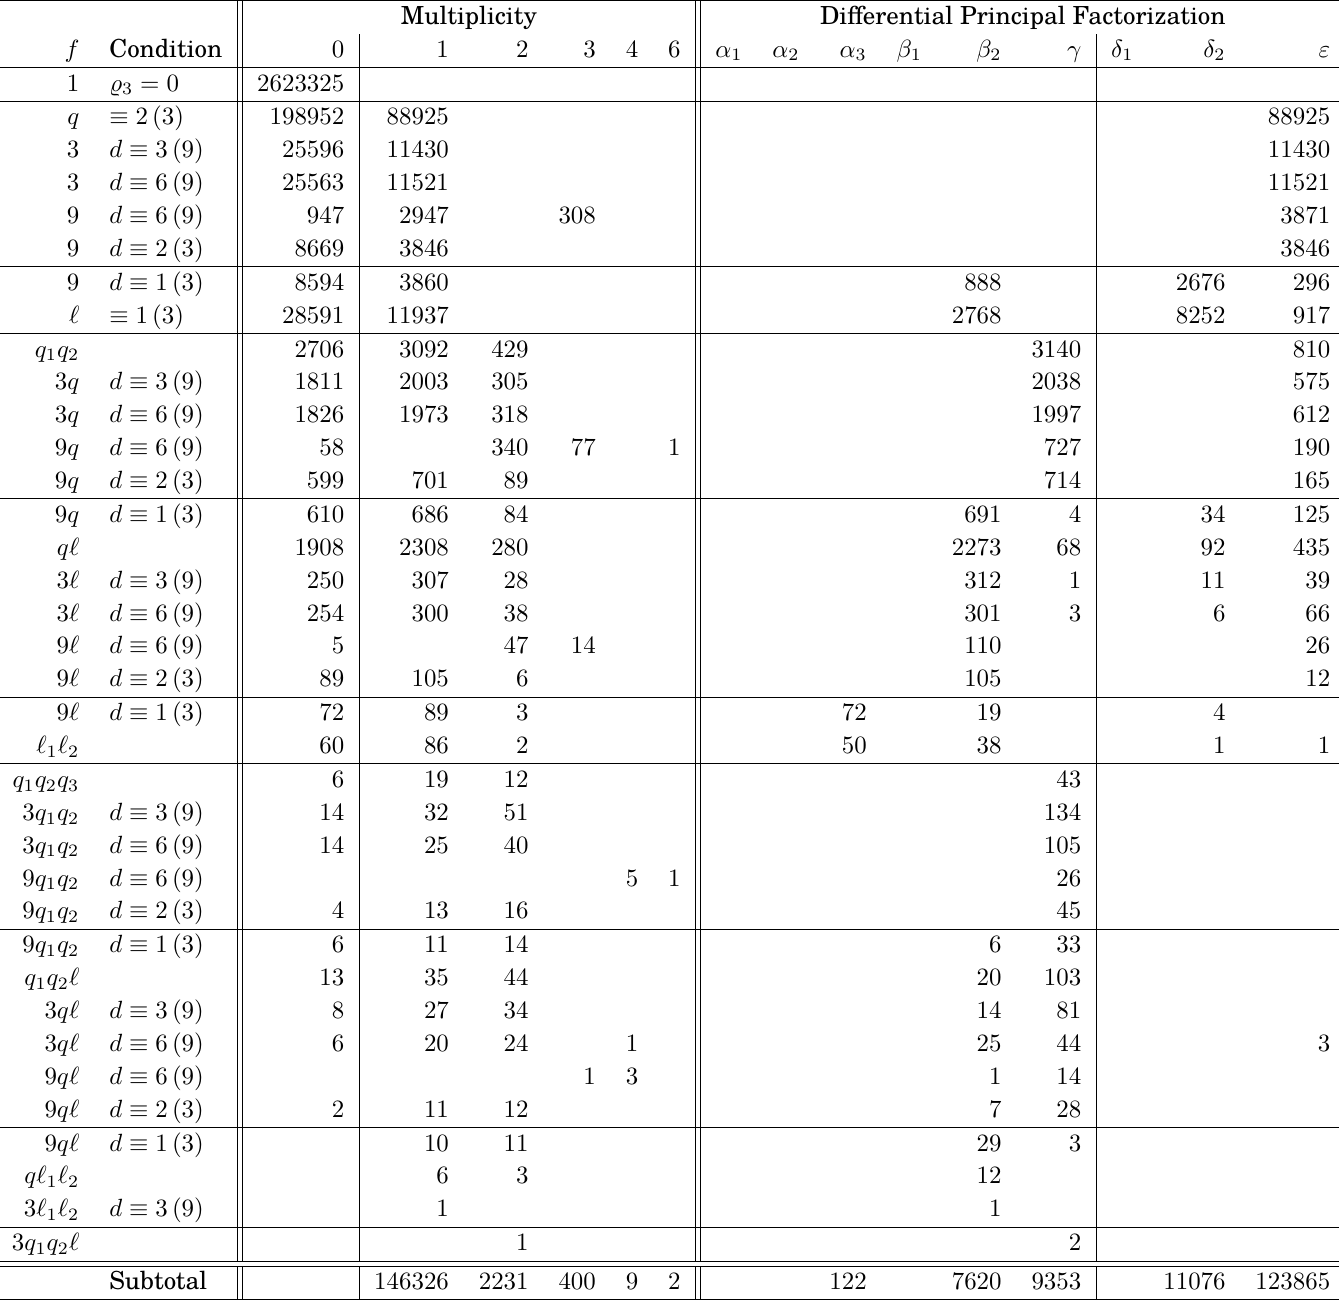
Table 13: Totally real cubic discriminants d L = f 2 · d in the range 0 < d L < 10 7 . Multiplicity Differential Principal